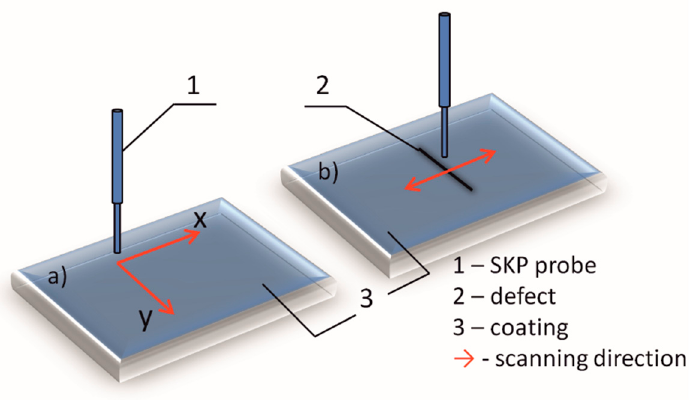
Figure 2. Schematic presentation of SKP measurements: ( a ) surface scanning on unbounded coatings and ( b ) line scanning over artificial defect.